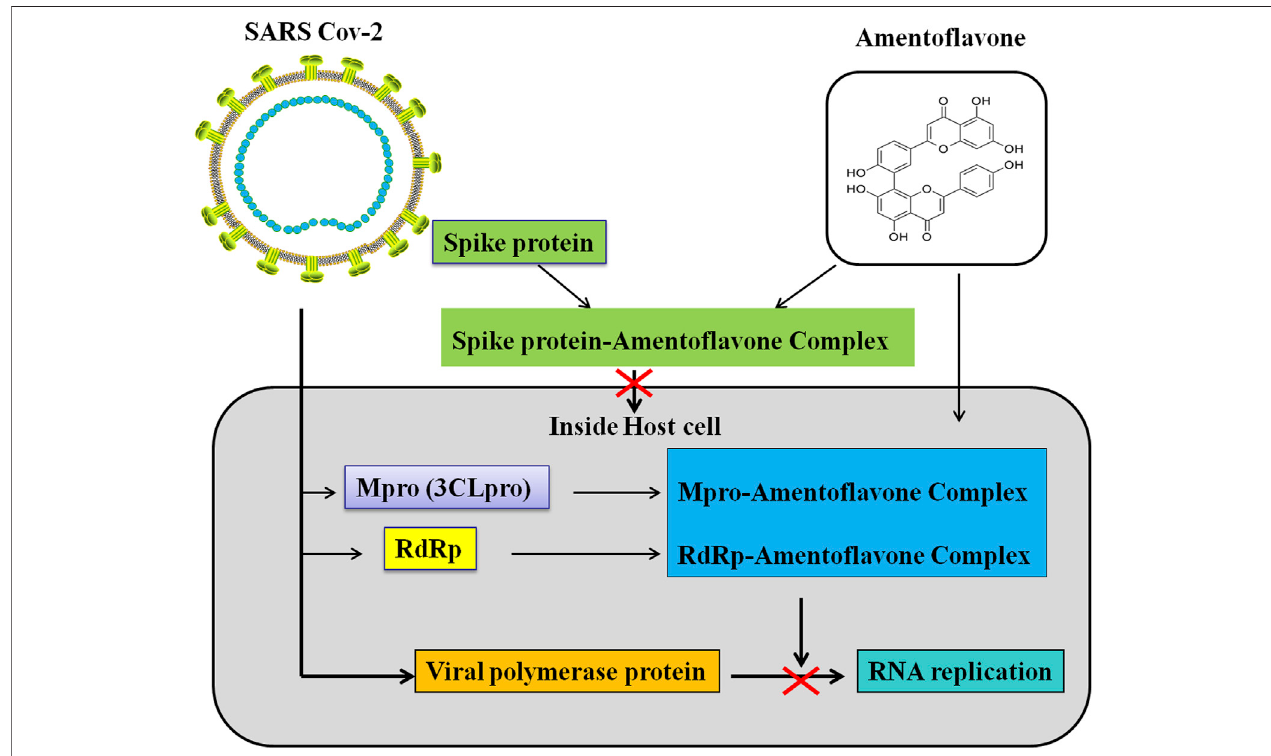
FIGURE 4 | Schematic representation for the functions of AMF in SARS-Cov 2 replication and transcription.